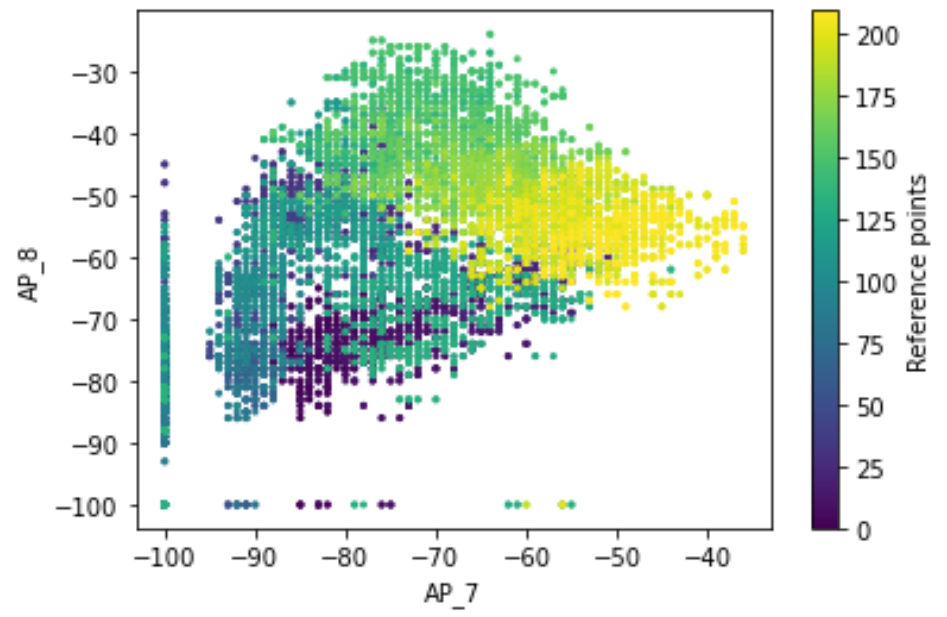
Figure 10. Distributions of RSS for Pair Wi-Fi APs of 7 and 8 for dataset A.